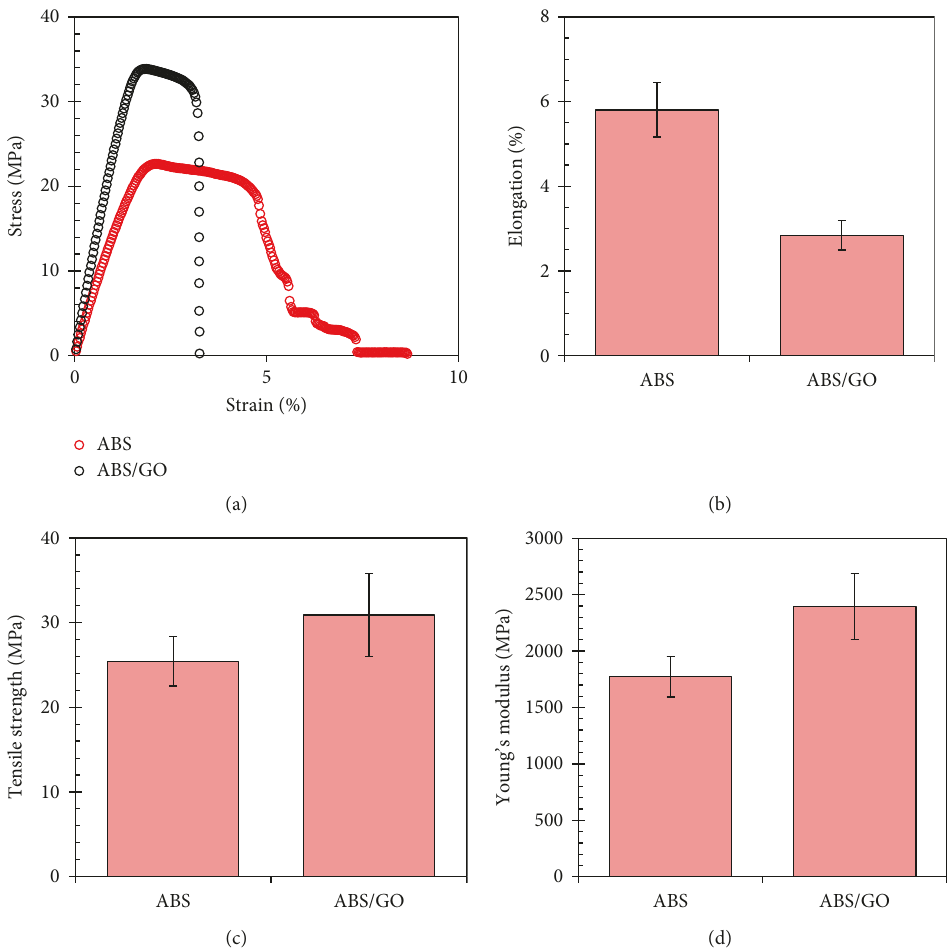
Figure 14: Typical stress-strain curves (a), value of elongation at break (b), tensile strength (c), and Young’s modulus (d) of ABS and ABS/GO printed